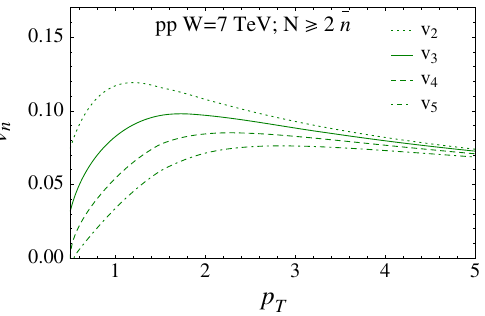
Fig. 6 v n versus p T for the proton–proton scattering at W =